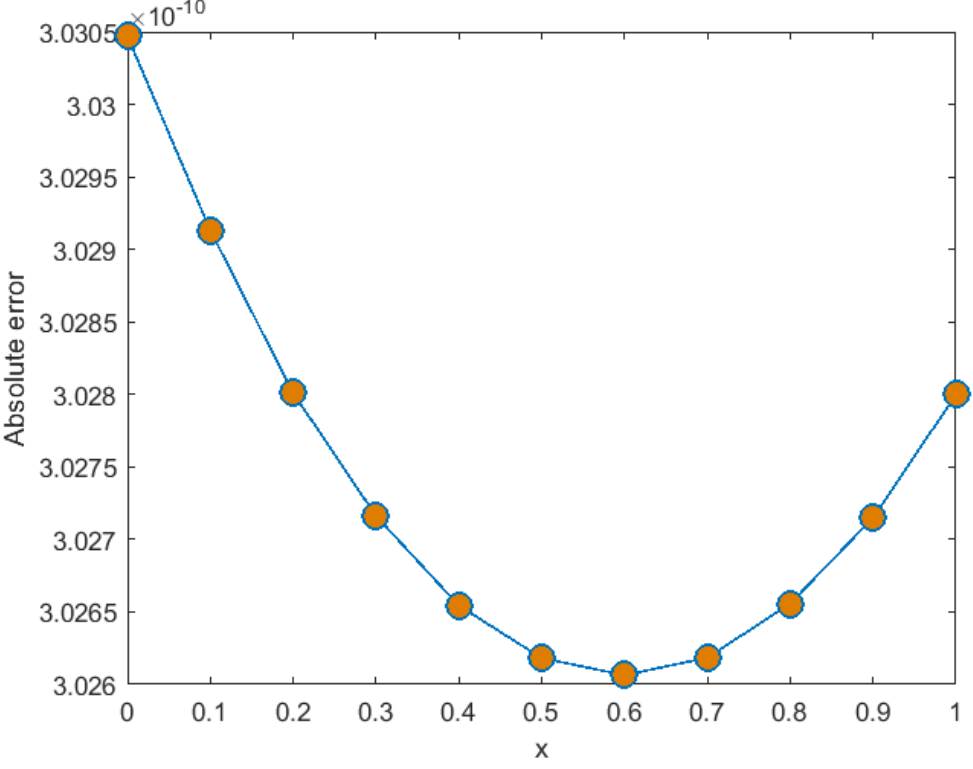
Figure 2. Absolute error of v ( x , t ) at t = 0.15 for Experiment